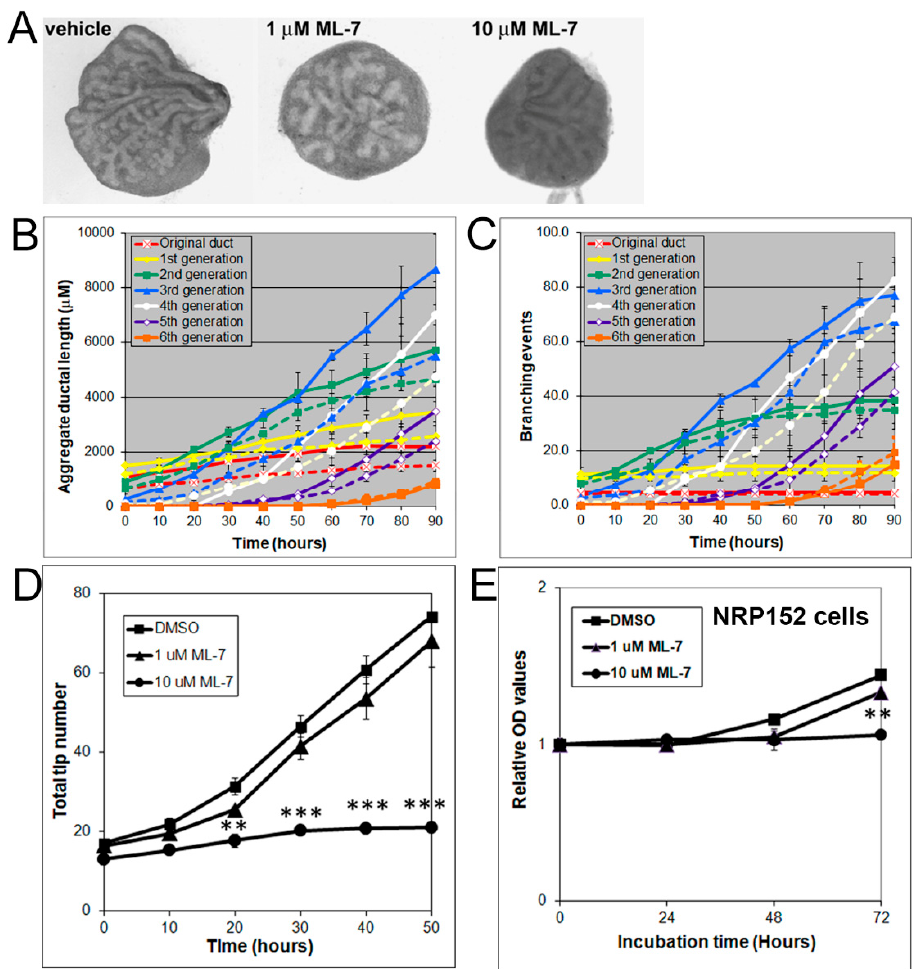
Figure 6. ( A ) Branching of rat pnd 0 VPs cultured for 40 h in the absence (left) or presence (middle and right) of 1–10 µ M ML-7. Successive images were taken every 30 min for 90 h to track branching events. Representative end-point images at 90 h are shown. Note that ML-7 dose-dependently inhibited branch formation in VPs. ( B ) Kinetics of prostatic bud and duct elongation over successive branch events in pnd 0 VPs cultured for 40 h in the absence (solid lines) or presence (dashed lines) of 10 µ M ML-7. Data show the aggregate length ( µ m) of all ductal segments in each successive branch generation over time. ( C ) Total number of branch point events in each ductal generation as a function of time. Solid lines represent data from untreated VPs, and dashed lines represent data from 10 µ M ML-7 treated VPs. Error bars denote SEM from 4 sets of experiments. Differences between the two groups were statistically significant ( p < 0.05) from 20 h onward except for the original ducts. ( D ) Total tip number in 3D analysis as a function of time in rat contralateral day 0 untreated VPs (squares) and ML-7 treated VPs (1 µ M triangles, 10 µ M circles) cultured for 40 h. Each data point represents the mean of 4 sets of experiments, and bars denote SEM. * denotes significant differences between controls and treatments, ** p < 0.01, *** p < 0.001. ( E ) Effects of an MLCK inhibitor on proliferation of cultured NRP152 rat prostate epithelial cells. NRP152 cells were treated with different doses of ML-7 (1, 10 µ M) for 24, 48, or 72 h. Cell proliferation activity was evaluated by an MTS cell proliferation assay using the CellTiter 96 ® AQ ueous non-radioactive cell proliferation assay kit. * denotes significant differences between control and treatments, ** p < 0.01, N =